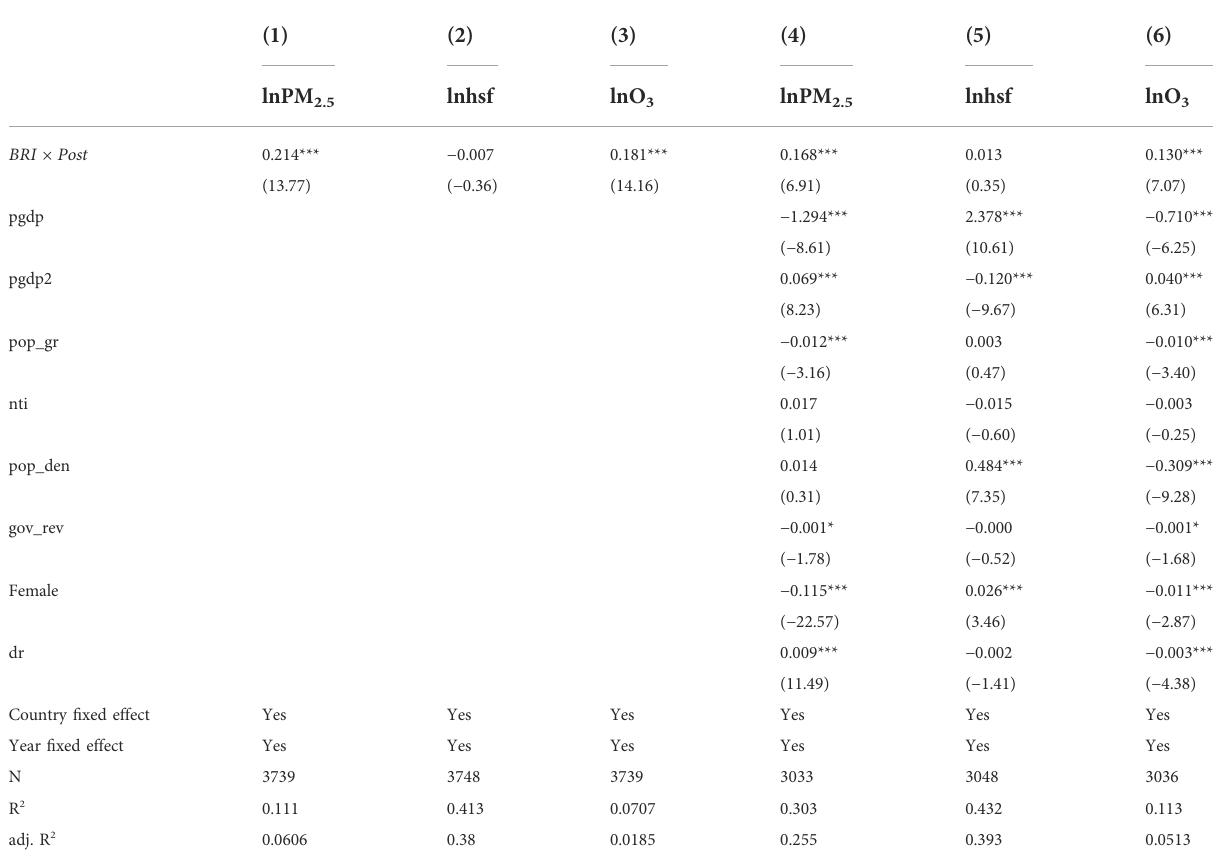
TABLE 17 Effects of the Green Belt and Road Initiative on environmental